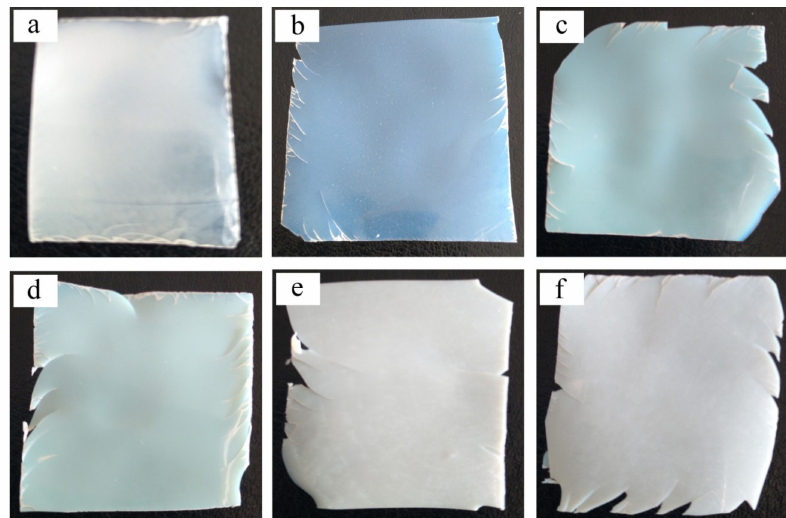
Figure 3. Photographs of latex films with different shell growth degrees: ( a ) PVAc core; ( b ) 30; ( c ) 60; ( d ) 90; ( e ) 120 min; ( f ) final